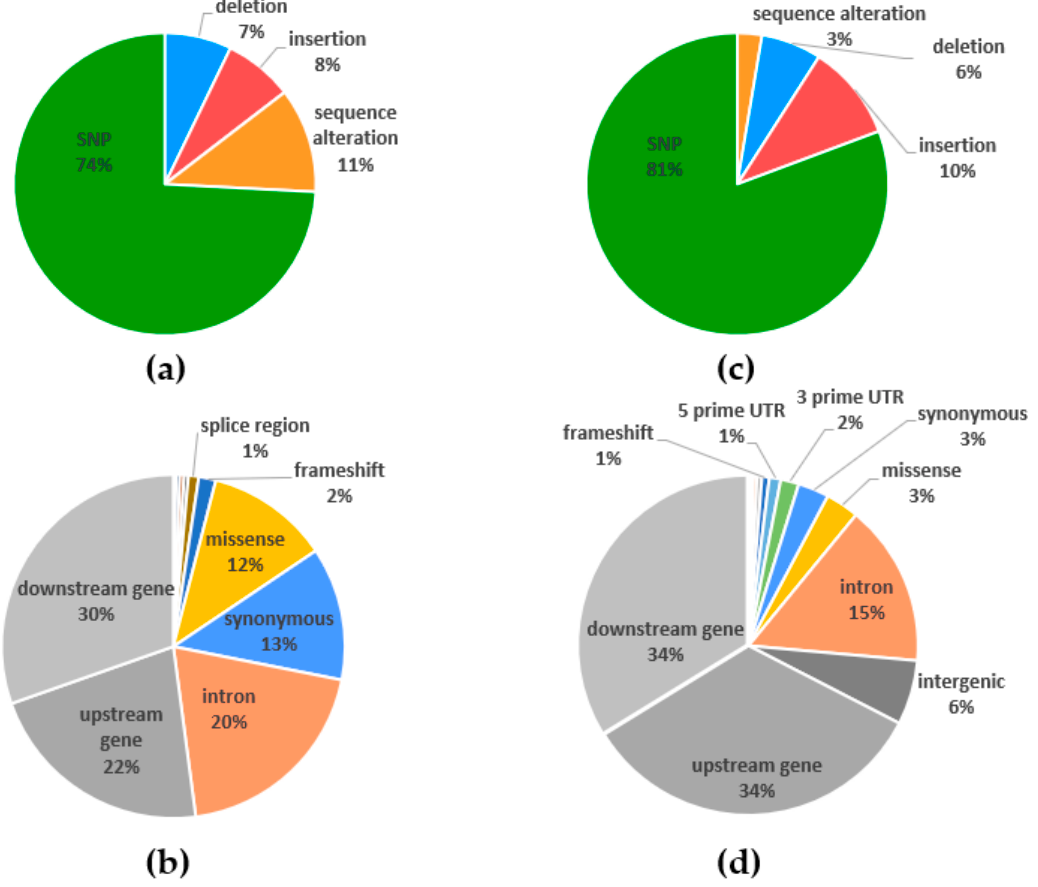
Figure 9. Polymorphism annotation of candidate genes for nitrogen fixation in red clover evaluated by hybridization-based sequence capture (SeqCap) ( a , b ) and whole-genome population genotyping double-digest restriction-site-associated sequencing (ddRADseq) ( c , d ). Distribution of polymorphism classes ( a , c ) and polymorphism consequences ( b , d ).